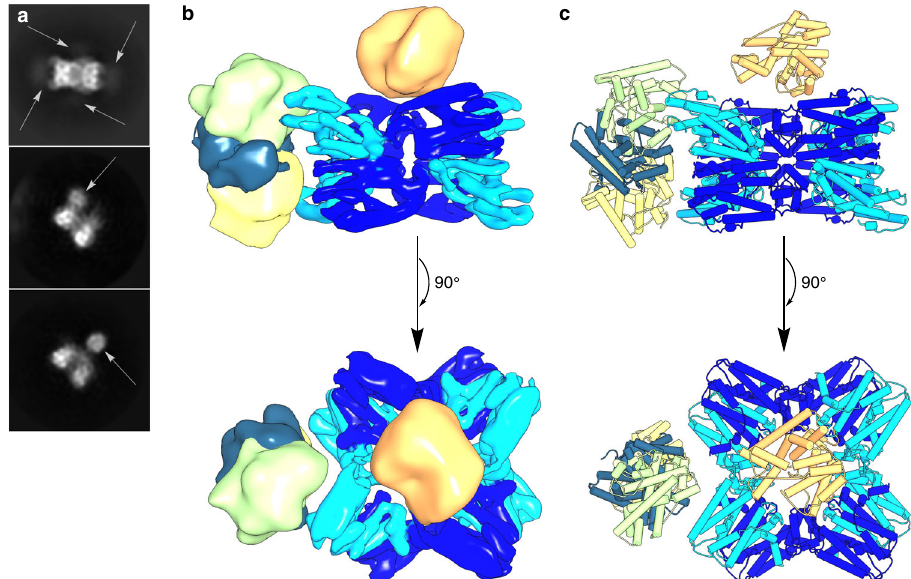
Fig. 3 Single cyclase domains observed by cryo-EM. a Selected 2D class averages of fi xed PaFS. Satellite domains are indicated by arrows. b Superimposed reconstructions of cyclase domains. Densities of the cyclase domain capping the central pore (orange, 11.9 Å resolution, contour 0.0191 in Chimera), symmetry-expanded (SE) class A (green, 8.5 Å resolution, contour 0.0132 in Chimera), SE class B (steel, 8.6 Å resolution, contour 0.0172 in Chimera), and SE class C (yellow, 9.4 Å resolution, contour 0.0203 in Chimera) were segmented from their respective full maps and superimposed with the fi nal 7.4 Å resolution map (combining SE classes A – C) displaying prenyltransferase domains (blue and deep sky blue, contour 0.040 in Chimera). Cyclase domains are less well-resolved compared to the octameric core and do not appear at the contour displayed in the pooled map. c Atomic models of